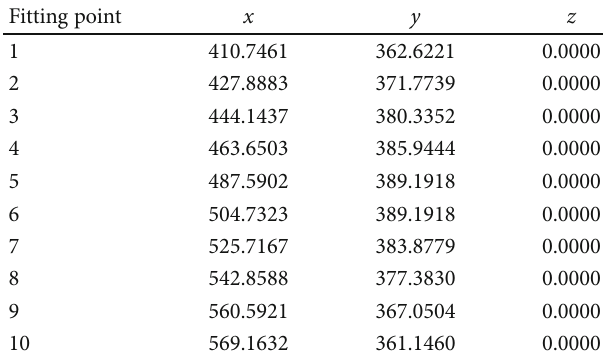
Table 3: Coordinates of fi tting points of spline curves.